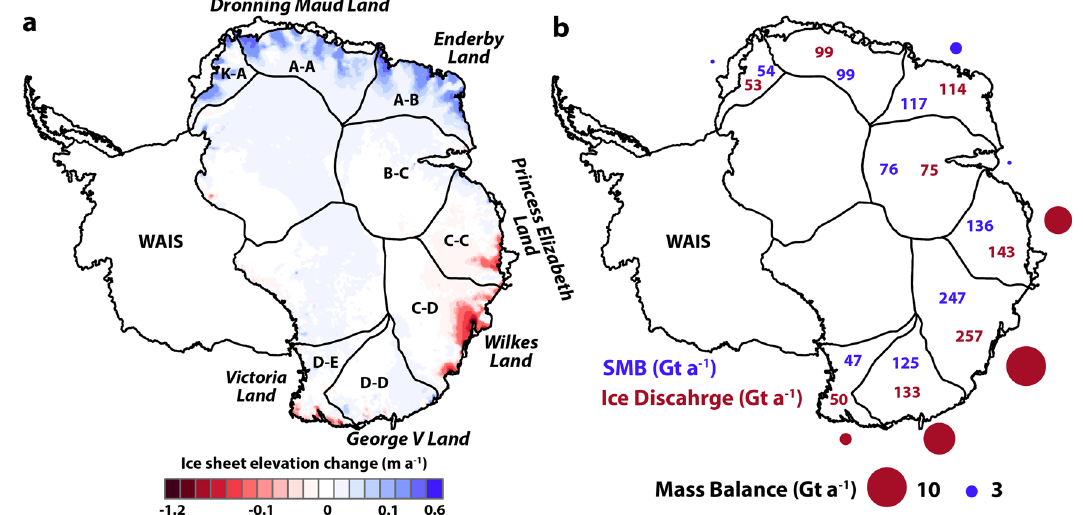
Fig. 1 | The current state of East Antarctic mass balance. 2003 – 2019 East Ant- arctic annual elevation change ( a ), adapted from Smith et al. 54 . 1979 – 2017 East Antarctic mass balance ( b ), with surface mass balance (blue numbers), ice dis- charge (red numbers) and mass balance (circles, red for negative and blue for